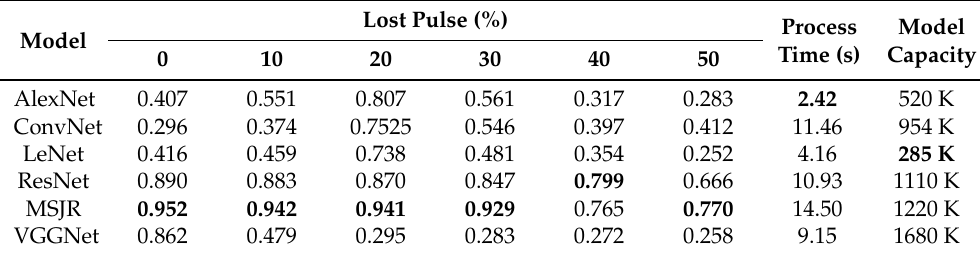
Table 5. Network performance comparison. The comparison results of accuracy under different noise levels, processing time, and model capacity of AlexNet, ConvNet, LeNet, ResNet, MSJR, and VGGNet. The bold part indicates the optimal